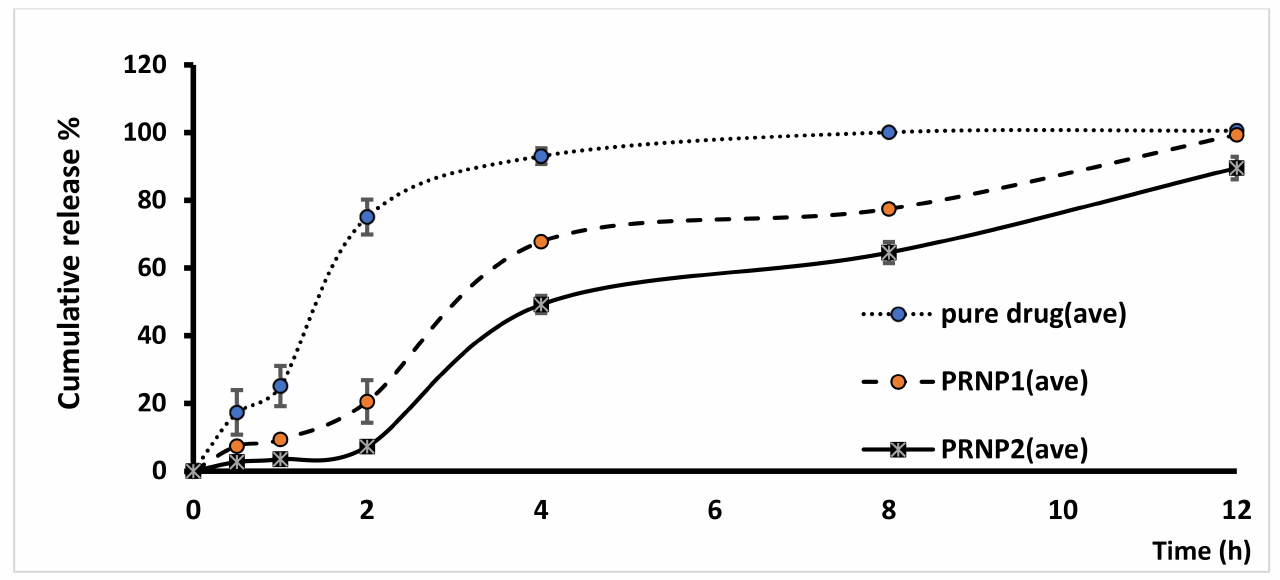
Figure 5. Release profile of doxycycline from prepared polymeric nanoparticles prepared by nano- precipitation